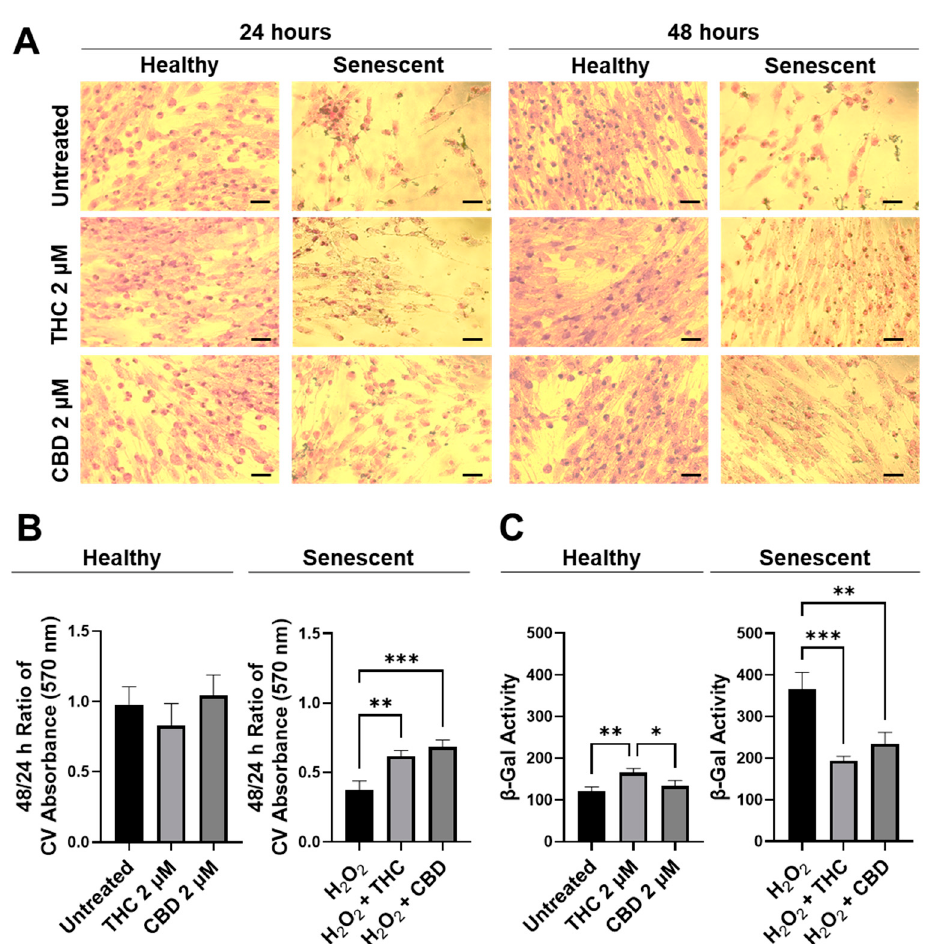
Figure 3. CV-stained fibroblasts, β -Gal activity, and 48/24 h CV assay ratio in healthy and SIPS CCD-1064Sk human dermal fibroblasts (PDL 24) exposed to 2 µ M of THC or CBD. ( A ) Images of healthy and senescent fibroblasts stained with CV after 24 or 48 h of treatment. Scale = 50 µ m. ( B ) The 48-to-24-h ratio of CV assay performed after treatment with THC or CBD exposure in healthy and SIPS fibroblasts. ( C ) β -Gal activity after 5 days of treatment with THC or CBD in healthy and SIPS fibroblasts. Data were analyzed with an ANOVA test followed by Tukey’s post-hoc multiple comparison test. Bars represent mean ± SEM, n = 3. Significance is indicated using the following scale: * p < 0.05, ** p < 0.01, *** p < 0.001. CBD, cannabidiol; CV, crystal violet; DMSO, dimethyl sulfoxide (vehicle); SIPS, stress-induced premature senescence; THC, delta-9-tetrahydrocannabinol.